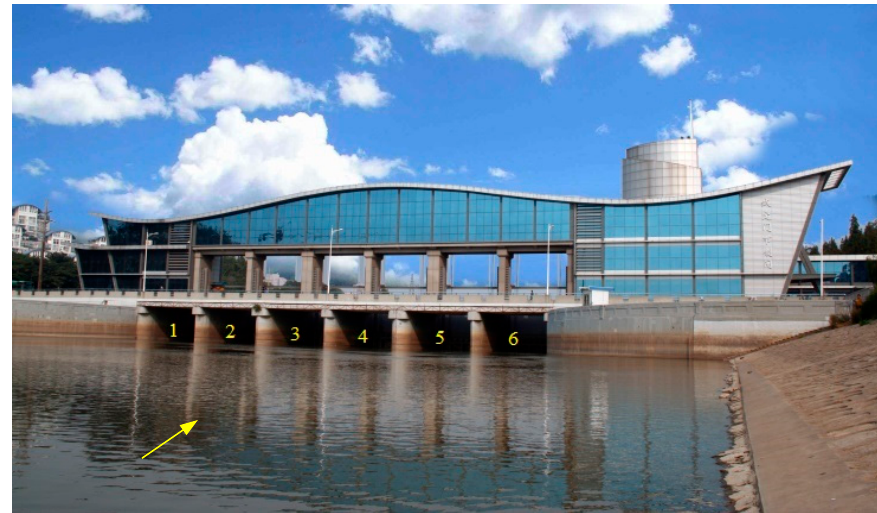
Figure 1. Sluice structure centrally placed in the river course, with six bulkhead gates and connecting abutment on each side (looking downstream).